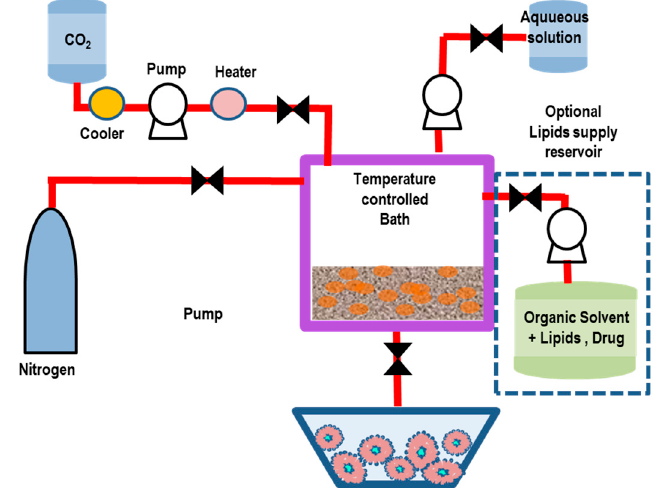
Figure 13. Schematic representation of the DELOS method. The lipids dissolved in organic solvent contained in a vessel at desired temperature and pressure, are mixed with SC-CO 2 (used as a co- solvent to the organic solvent). Then, the mixture (depressurized at 35–55 bar) is expanded into CO 2 , and injected through a nozzle into in a vessel containing water bath and active drugs, where the liposomes are formed.